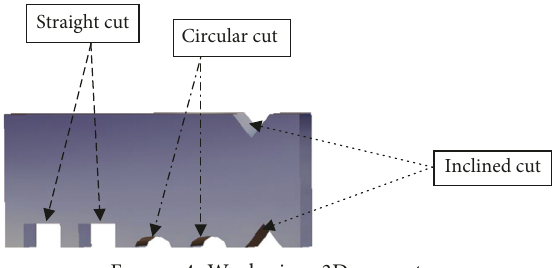
Figure 4: Work piece 3D geometry.